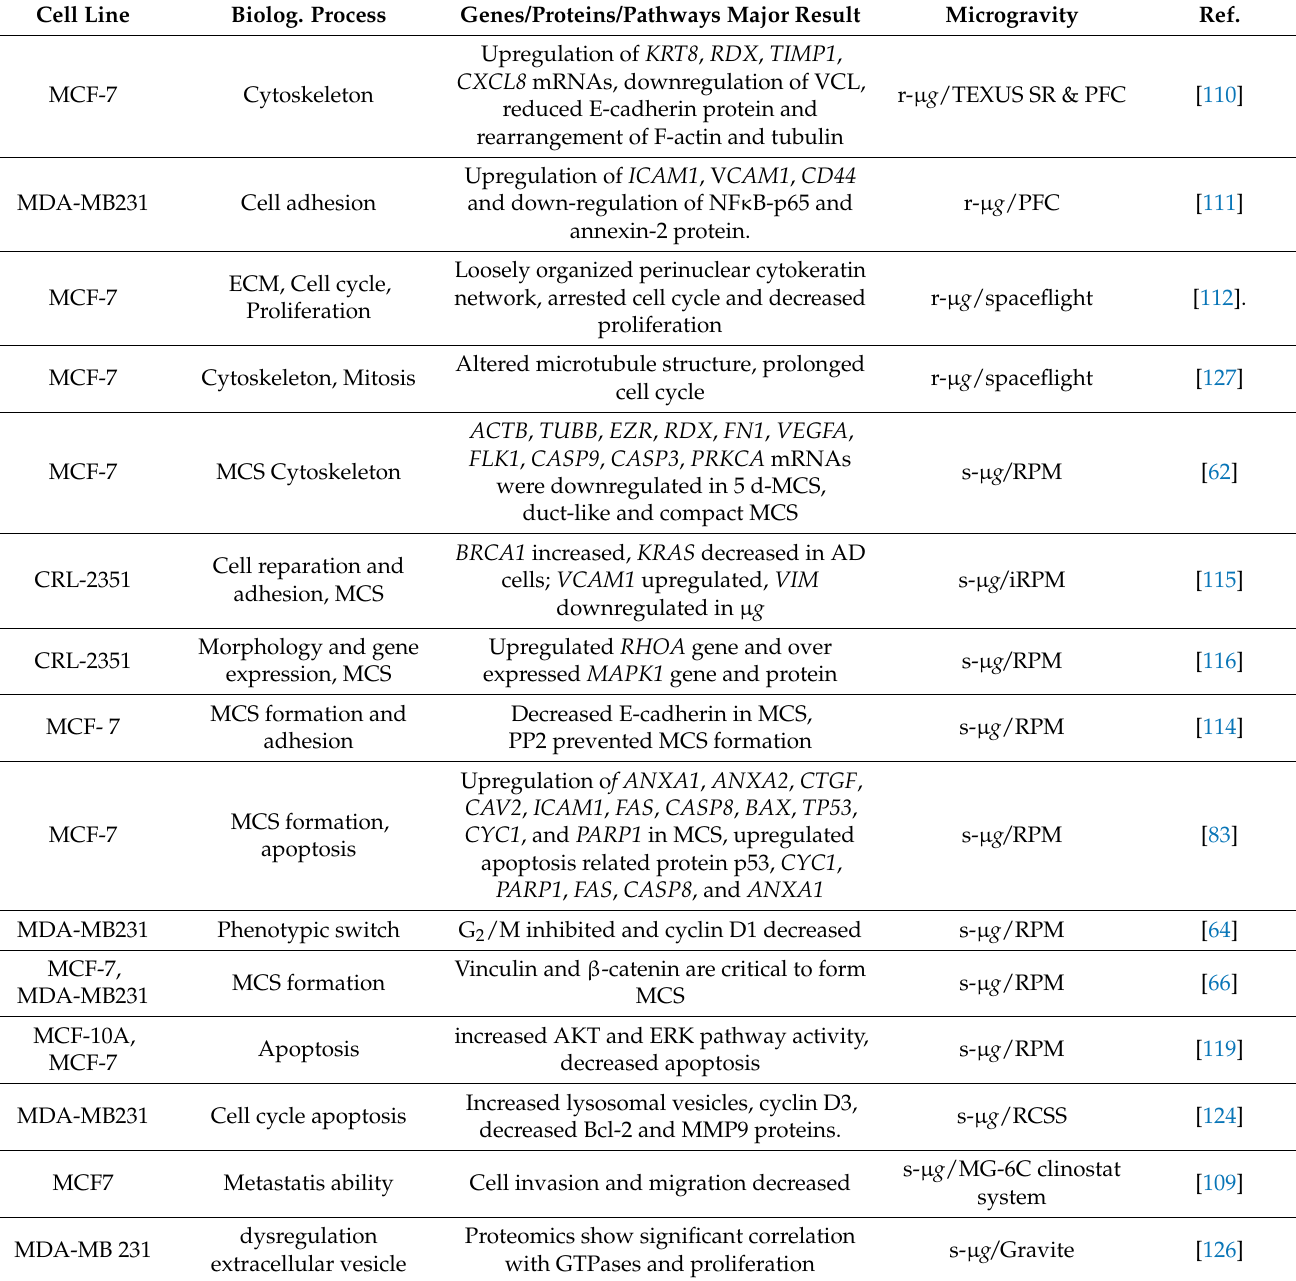
Table 2. Genes and proteins, involved in BCC spheroid formation under microgravity